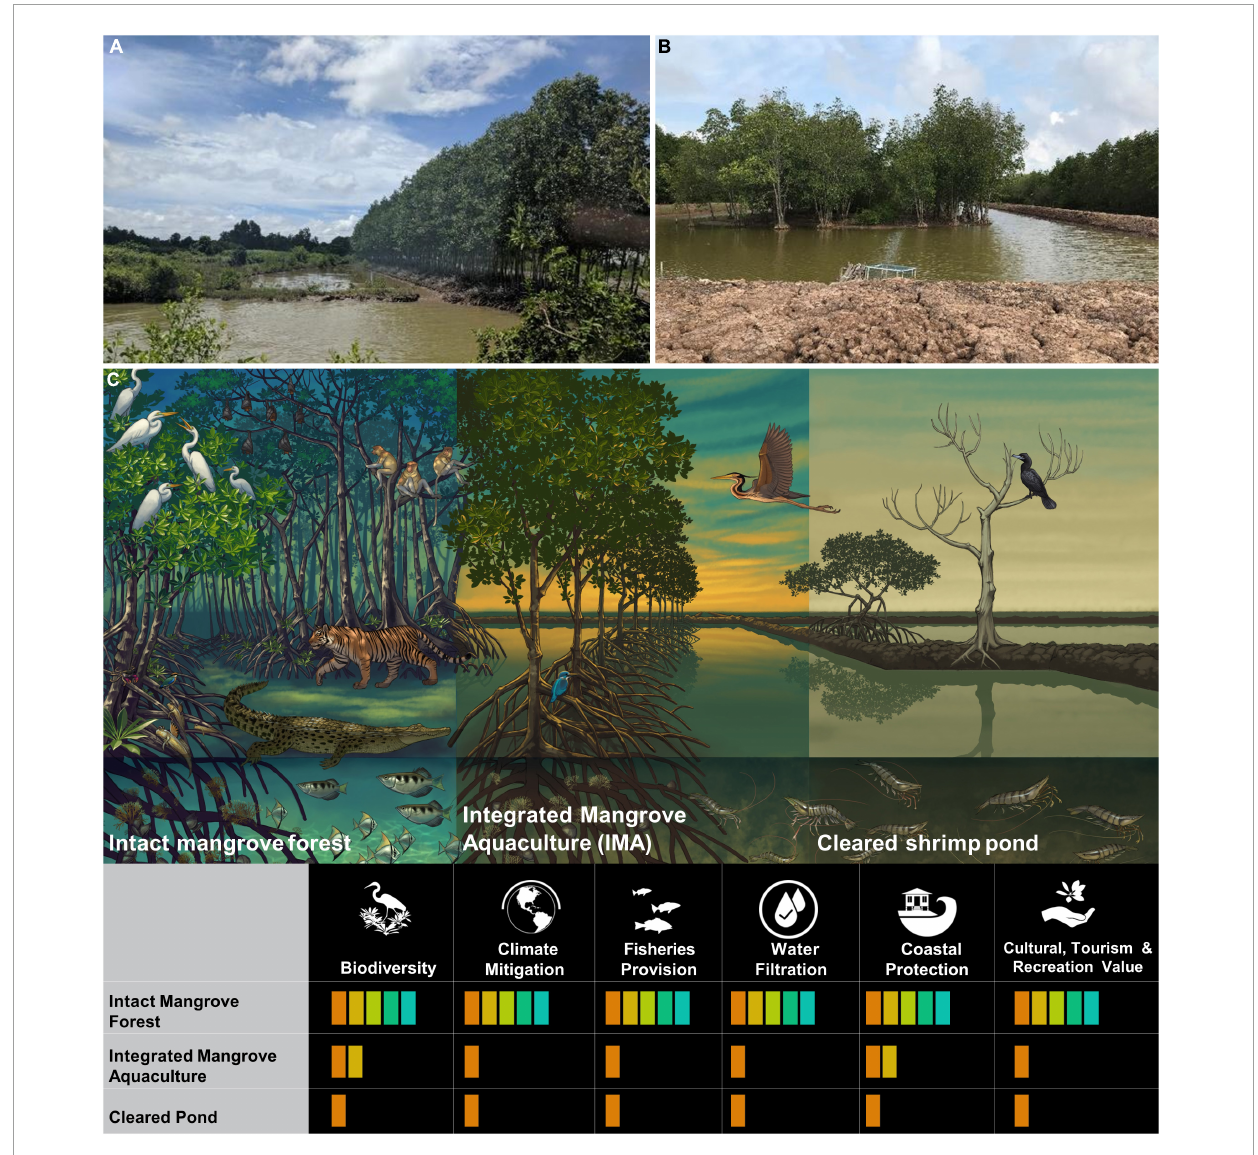
FIGURE1 Common layouts for integrated mangrove aquaculture and their benefits for biodiversity and ecosystem service provision. Integrated mangrove aquaculture shrimp systems showing: (A) Mmangroves directly adjacent to the pond on the pond walls, and (B) mangroves within the pond as a central mass. (C) Stylized differences between intact mangrove forests, integrated mangrove aquaculture, and cleared shrimp ponds and their value for biodiversity and ecosystem service